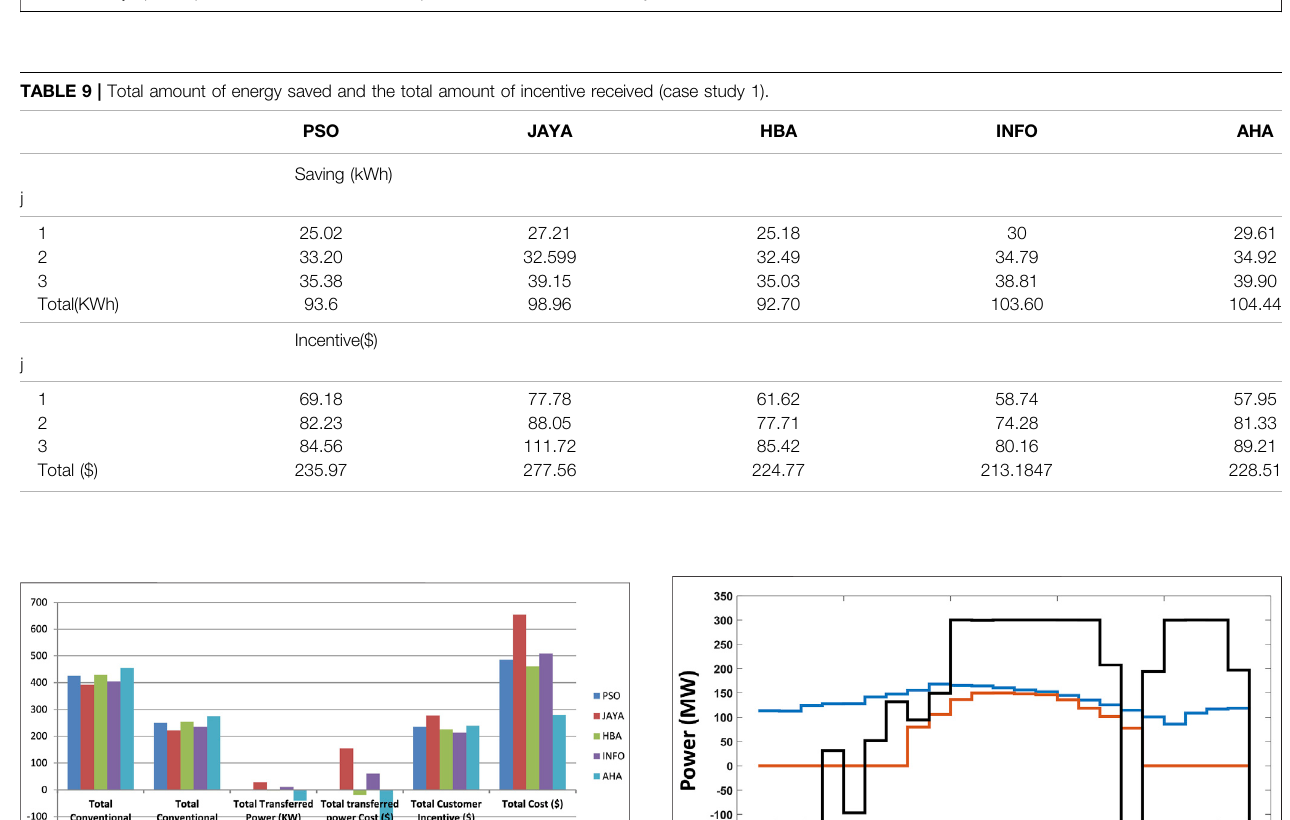
FIGURE 7 | Optimal power curtailed and incentive paid to customers obtained by the AHA.